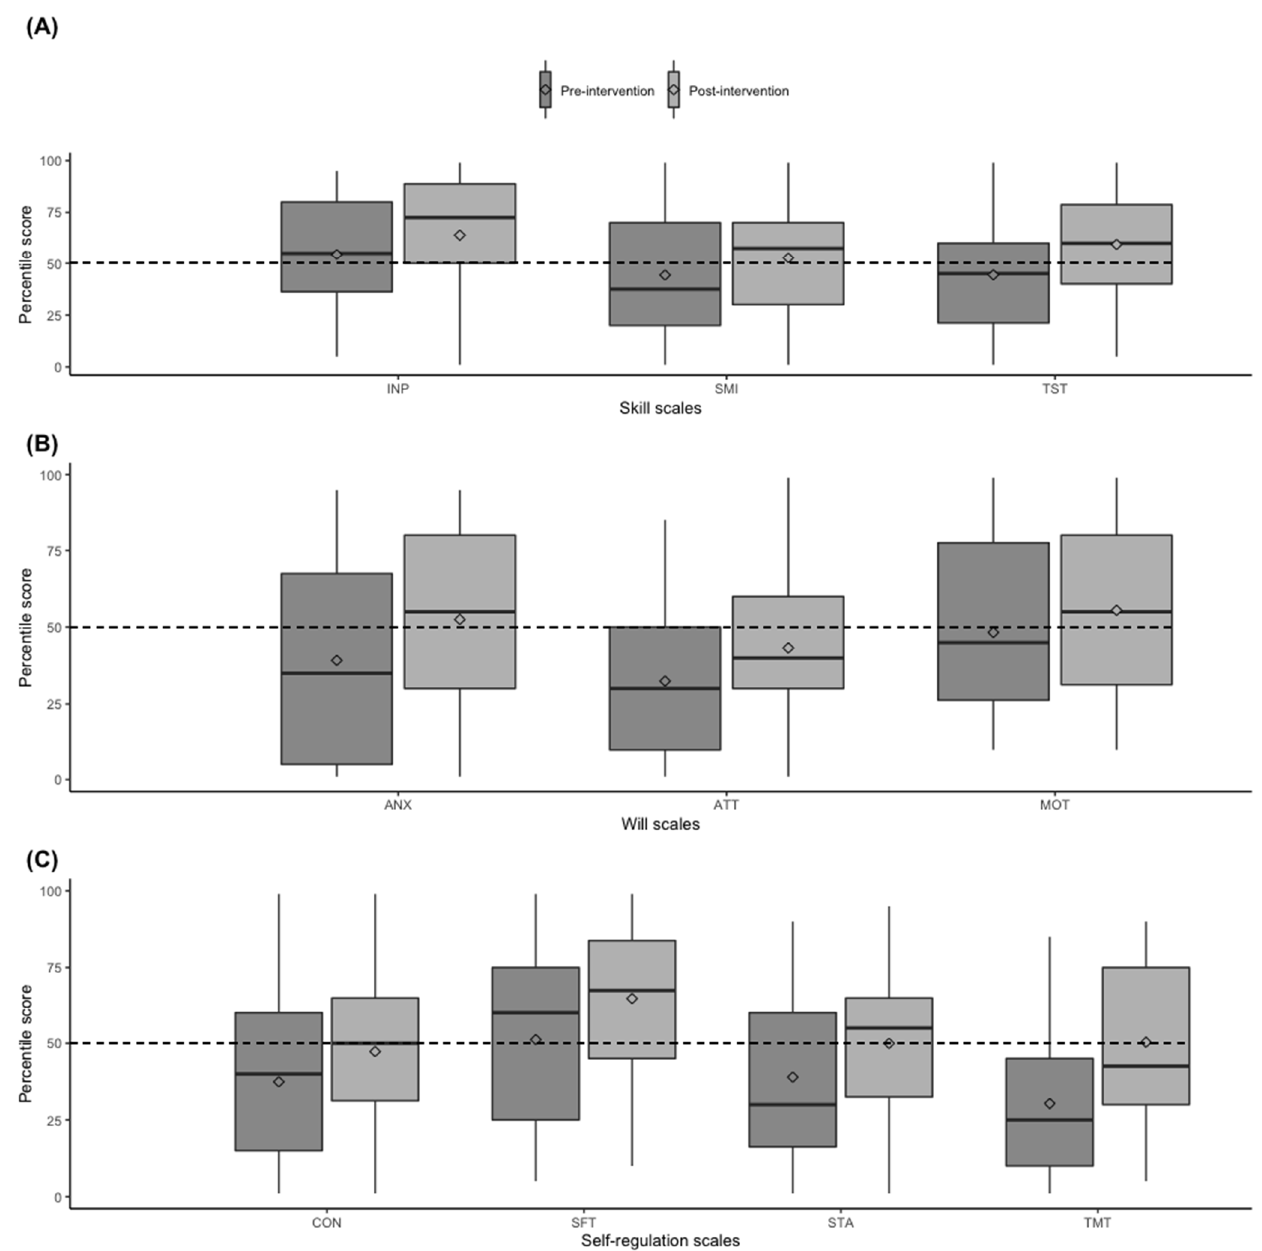
Figure 2. Comparison of pre- and post-LASSI test scores by scale components attained during the USFQ’s Keys to Academic Success Program. Dark gray and light gray boxes correspond to pre- and post-intervention results. Data are shown as median and 25th and 75th percentiles (boxes) and a full range of values (whiskers). Panel ( A ) shows the scales of the Skill component. Panel ( B ) shows the scales of the Will component. Panel ( C ) shows the scales of the Self-regulation component. Abbreviations: INP, Information Processing; SMI, Selecting Main Ideas; TST, Test Strategies; ANX, Anxiety; ATT, Attitude; MOT, Motivation; CON, Concentration; SFT, Self-Testing; STA, Study Aids; TMT, Time Management. Diamond figure depicts the mean value.